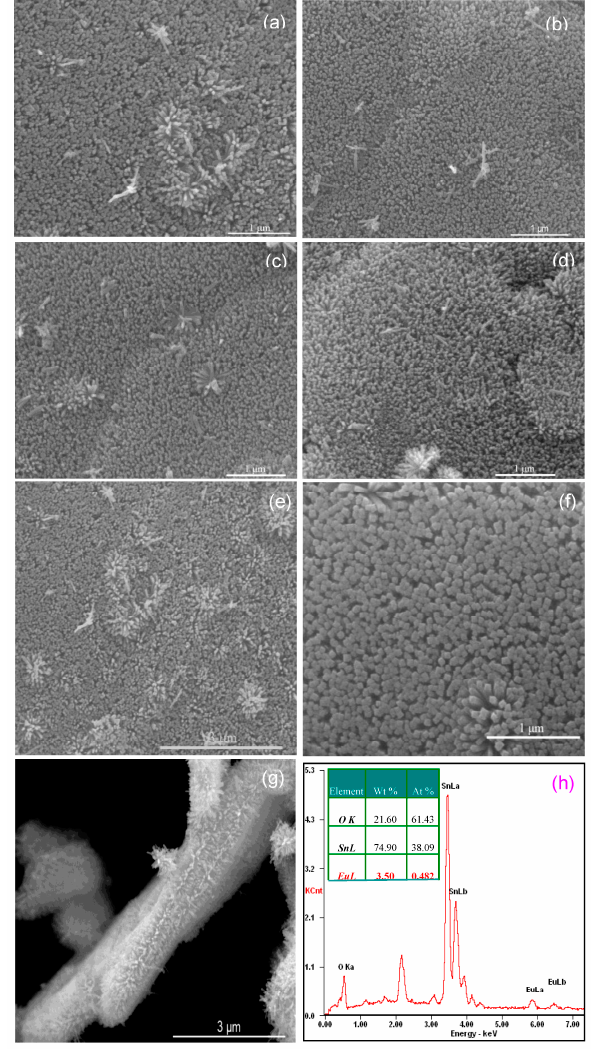
Figure 2. ( a – e ) Top-view SEM image of 0.2, 0.5, 1.0, 1.5, and 3.0 at % Eu-doped SnO 2 nanorods array; ( f ) Undoped SnO 2 nanorods array SEM image; ( g ) Cross-sectional SEM image of 0.5 at % Eu-doped SnO 2 nanorods array; ( h ) EDX spectrum of 0.5 at % Eu-doped SnO 2 nanorods